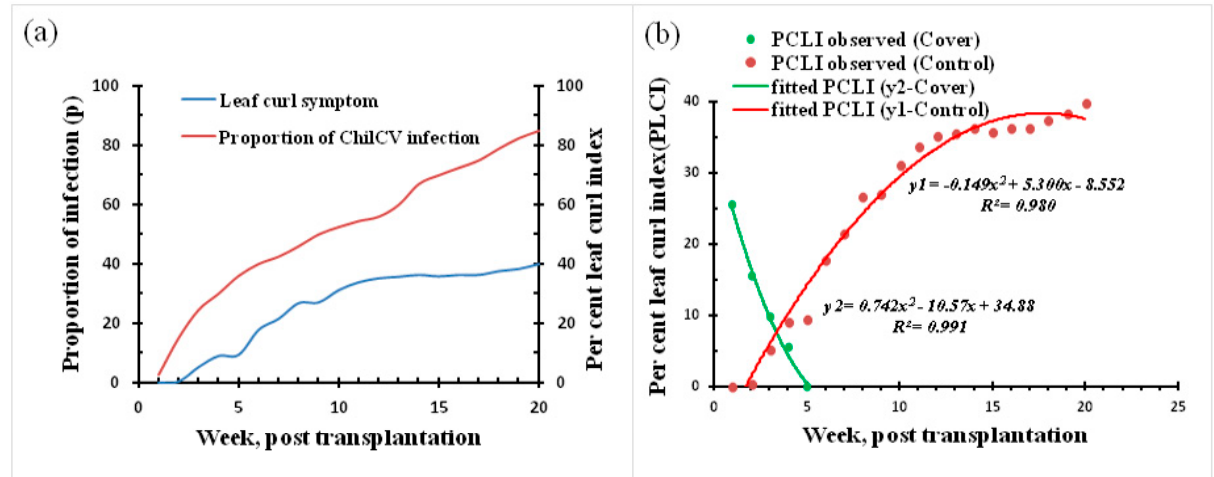
Figure 7. Leaf curl incidence at the IARI experimental field, New Delhi, in 2021; agroecosystem surrounded by susceptible crops, semi-natural perennial habitat, weeds, and borders with cucurbits and legumes. ( a ) Proportion of ChiLCV infection and percent leaf curl index; ( b ) intersect and optimum interception time